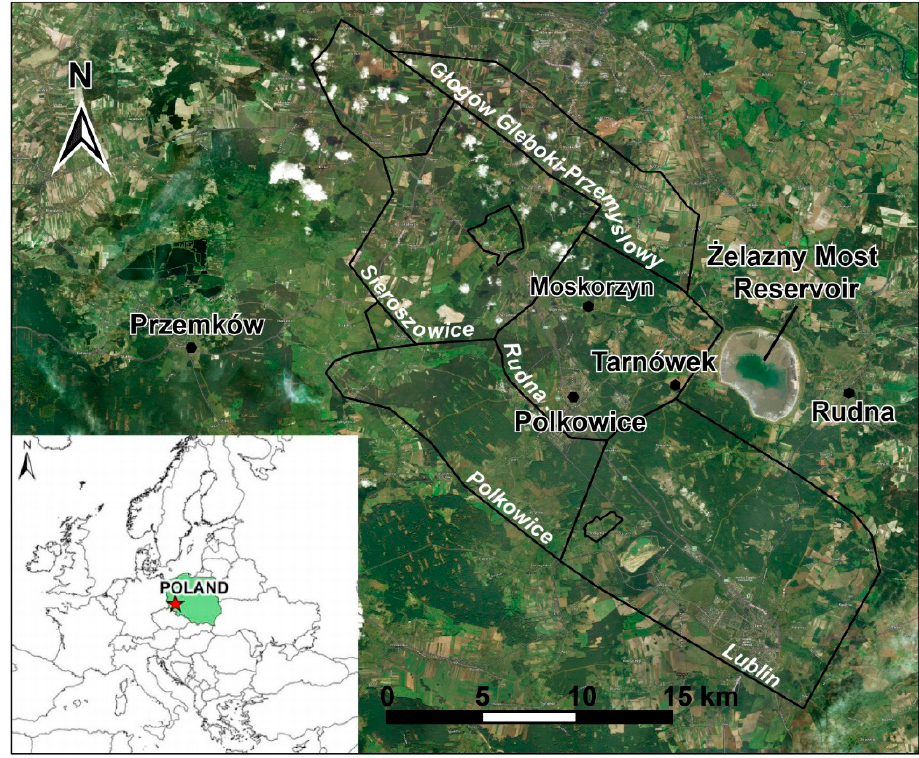
Figure 1. Satellite view of the Legnica Glogow Copper District (from Google Earth); mine district borders are shown in black lines (from http://dm.pgi.gov.pl/, accessed on 15 May 2021). Geological Setting